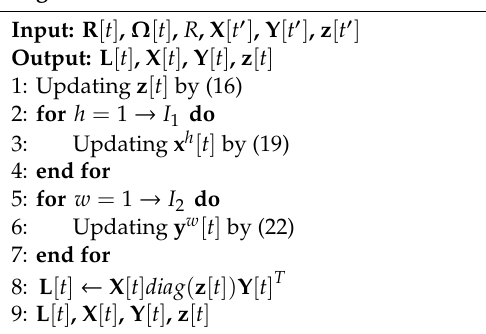
Algorithm 3 OLCP-InSAR for matrix